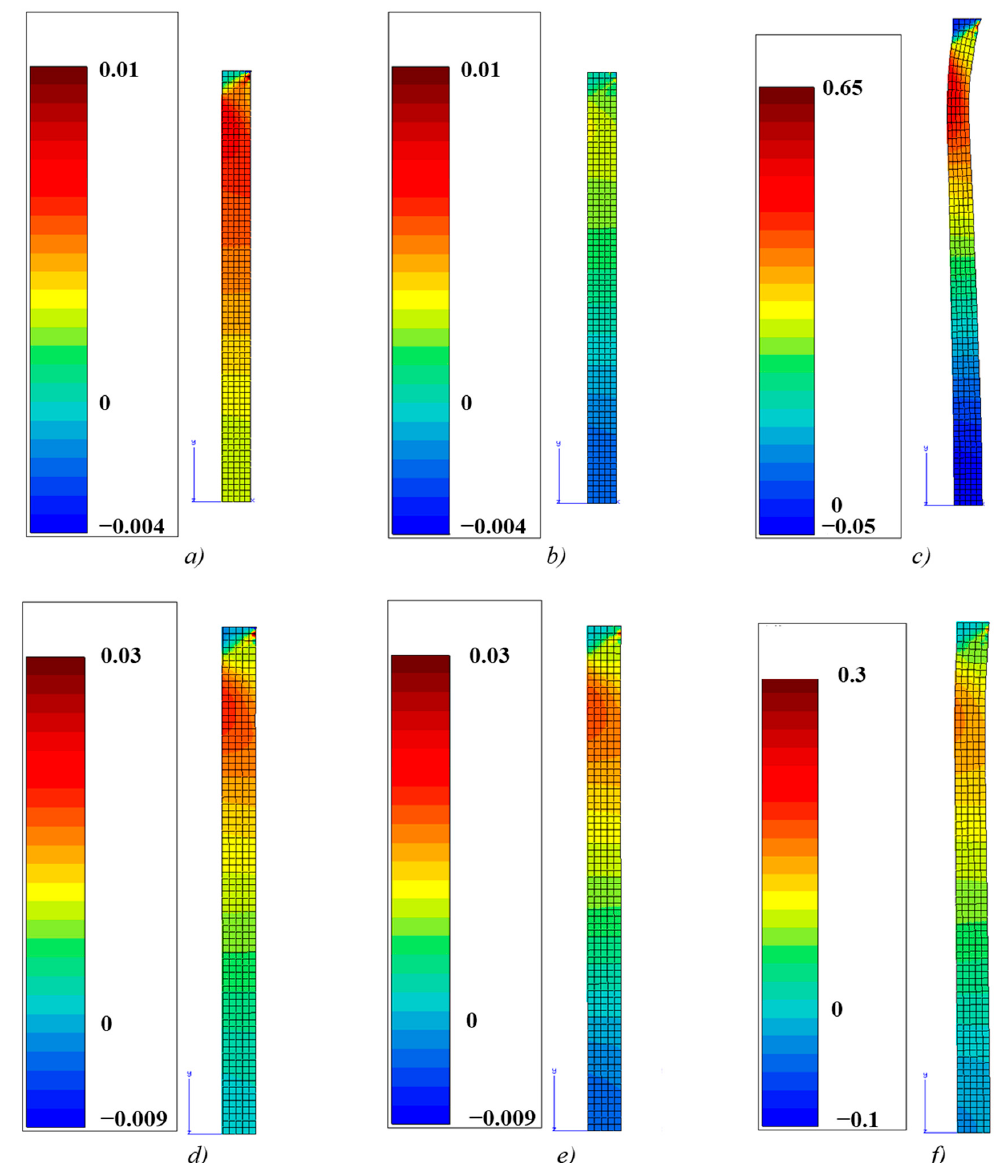
Figure 12. Total strain field on vertical axis for conditions T7 EV EP at ( a ) 250 s (tensile), ( b ) 300 s (compression) and ( c ) 19,700 s (cycle 197), and T7S EV EP at ( d ) 250 s (tensile), ( e ) 300 s (compression) and ( f ) 2300 s (cycle 23).